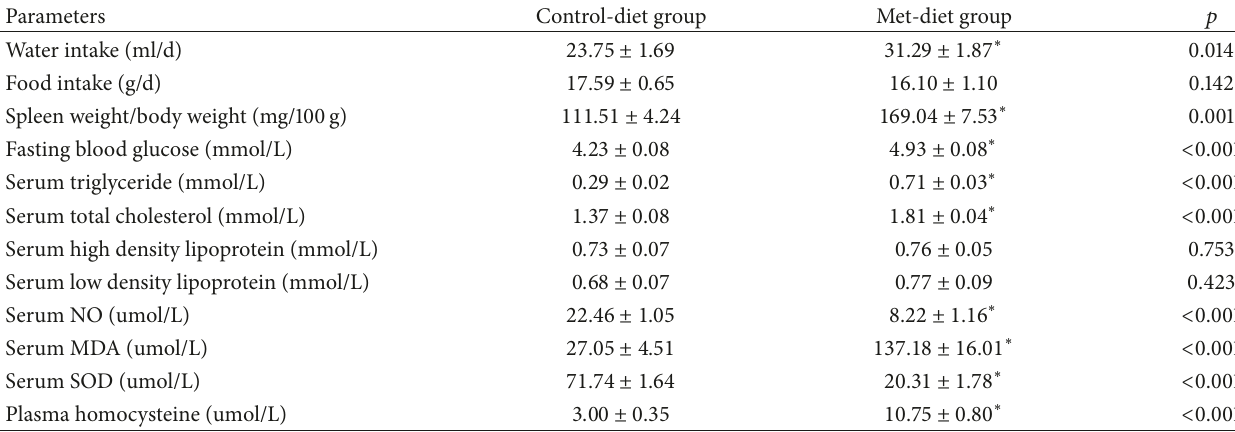
Table 1: Parameter values in Wistar rats after 48 weeks of treatment with control and methionine-supplemented diets ( 𝑛 = 6 /group). Parameters